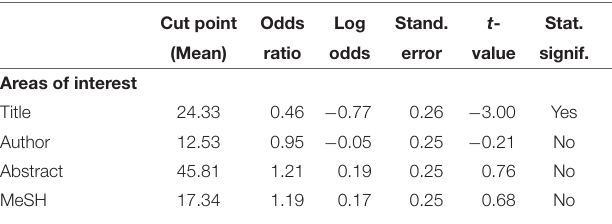
TABLE 5 | Summary of the relationship between number of mouse clicks and gaze (N number of mouse clicks = 256, N eye gaze = 256; statistical significance at 95%).